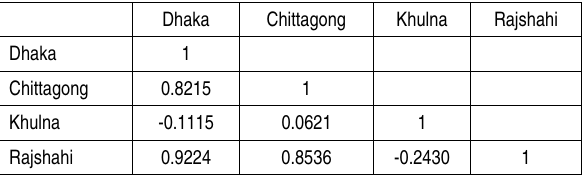
Table 8. Correlation matrix: all